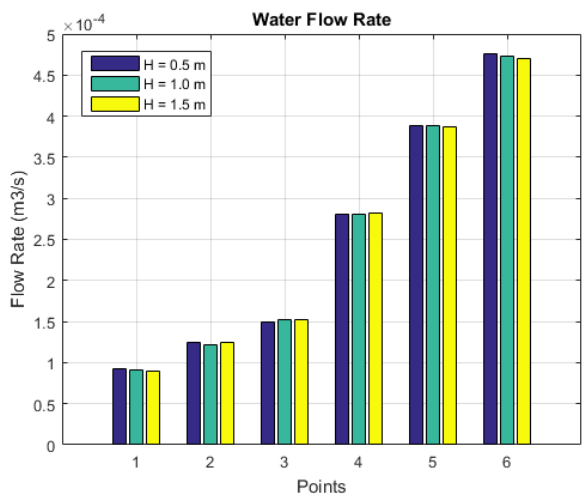
Fig. 8. Water flow rate during the experiment